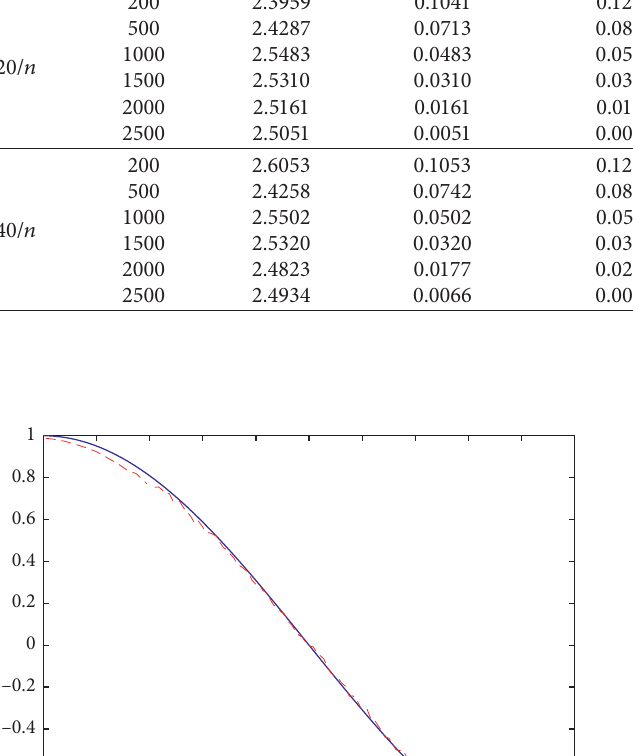
Table 4: The WLS estimators of β and g ( t ) and the absolute errors and RMSEs of 􏽢 β t